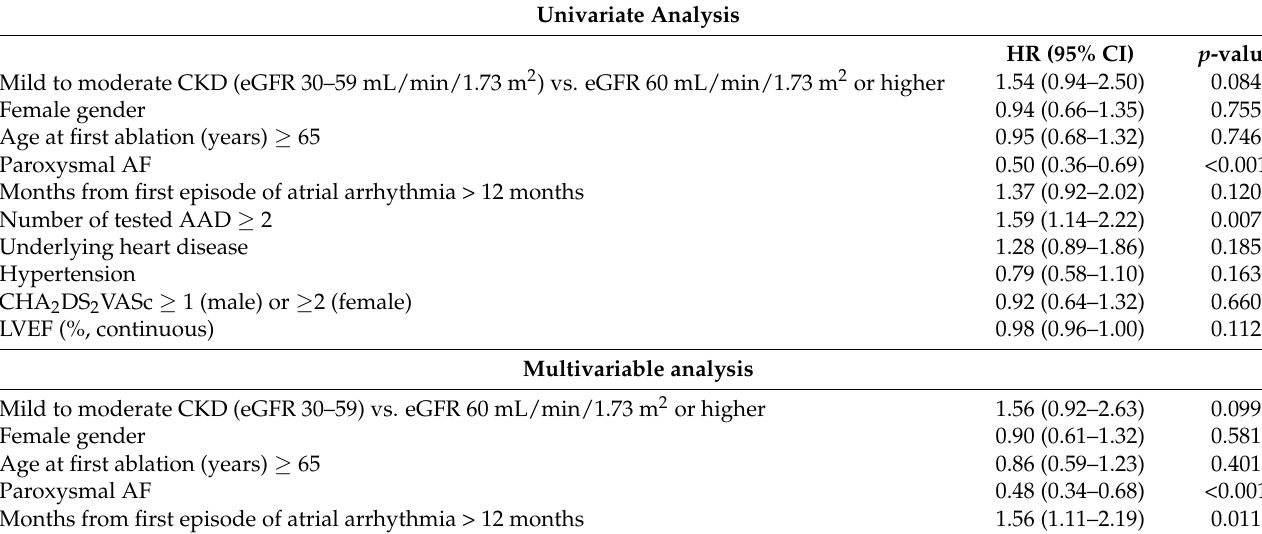
Table 4. Predictors of